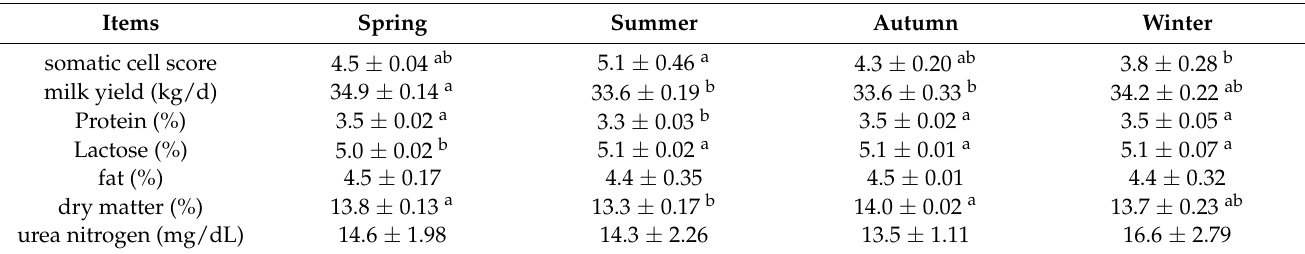
Table 1. The influences of seasonal changes on the Dairy Herd Improvement (DHI) index in cows.